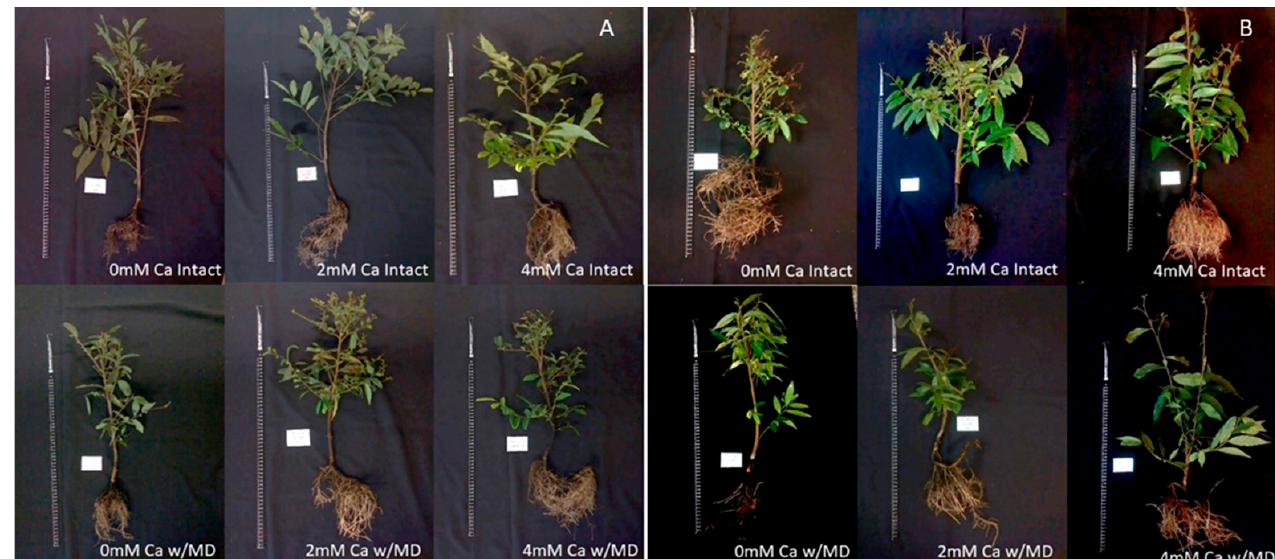
Figure 6. Annona emarginata plants submitted to the treatments: 0 mM Ca 2+ without mechanical damage (intact), 0 mM Ca 2+ with mechanical damage (w/MD), 2 mM Ca 2+ intact, 2 mM Ca 2+ w/MD, 4 mM Ca 2+ intact, and 4 mM Ca 2+ w/MD, at evaluation times: ( A ) 0 (30 min) and ( B ) 90 days. Plants grown with 2 mM Ca 2+ intact and 0 mM Ca 2+ w/MD showed a rapid decline in NAR and RGR (Figure 7). Plants with 4 mM Ca 2+ intact showed slow growth, observed by the stabilization of RGR after 30 days. In these plants, NAR showed a decrease, but later, at 90 days. Plants with 2 and 4 mM Ca 2+ w/MD and 0 Ca 2+ intact plants showed constant RGR. Plants with 0 mM Ca 2+ intact and plants with 4 mM Ca 2+ w/MD showed an increase in NAR over time.